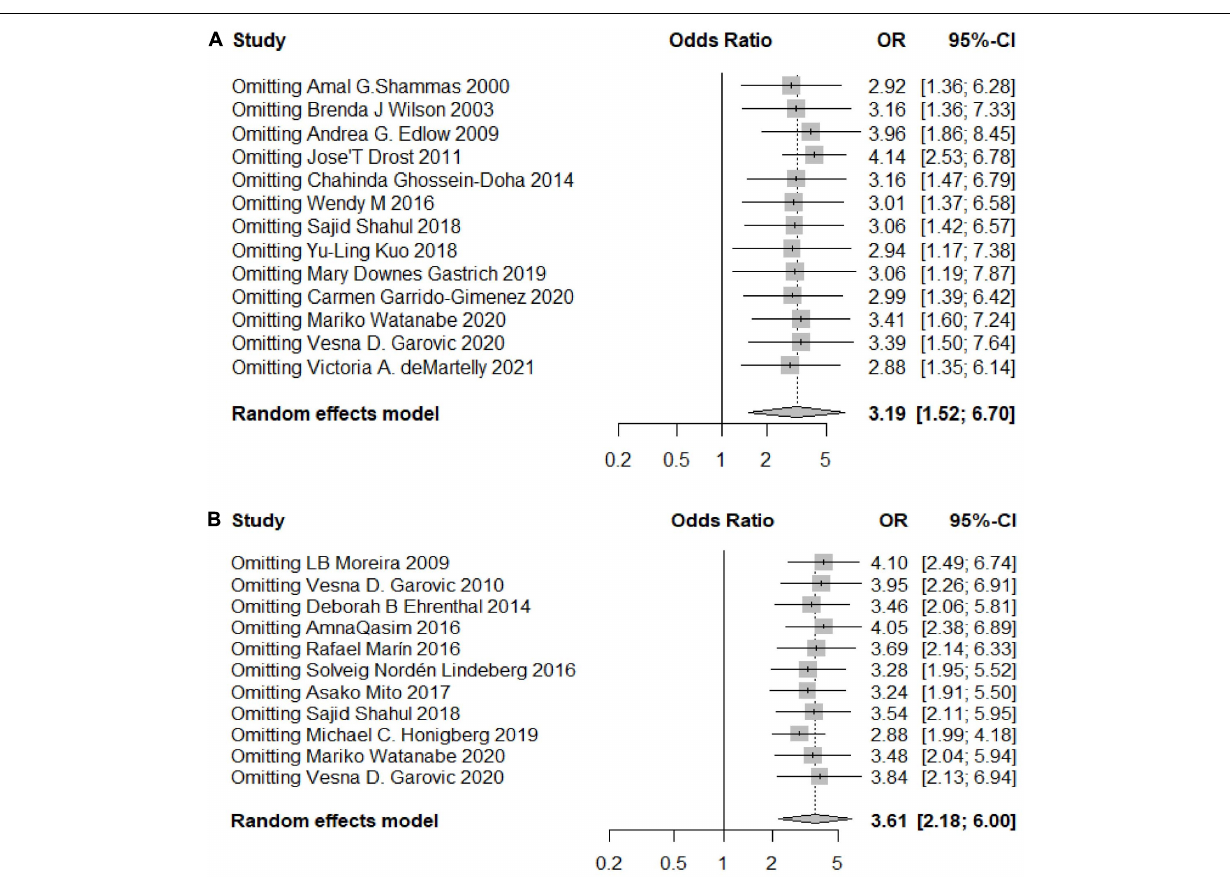
FIGURE 5 | Sensitivity analyses of the included studies. (A) Sensitivity analysis of the included studies for the HDP group; (B) sensitivity analysis of the included studies for the PE group.